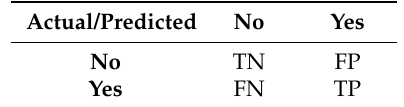
Table 4. Confusion matrix. FN: false negative; false positive; TN: true negative; TP: true